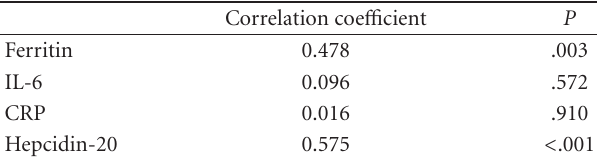
Table 2: Correlations between serum hepcidin-25 levels, inflamma- tion indices, and serum hepcidin-20 in HD patients.